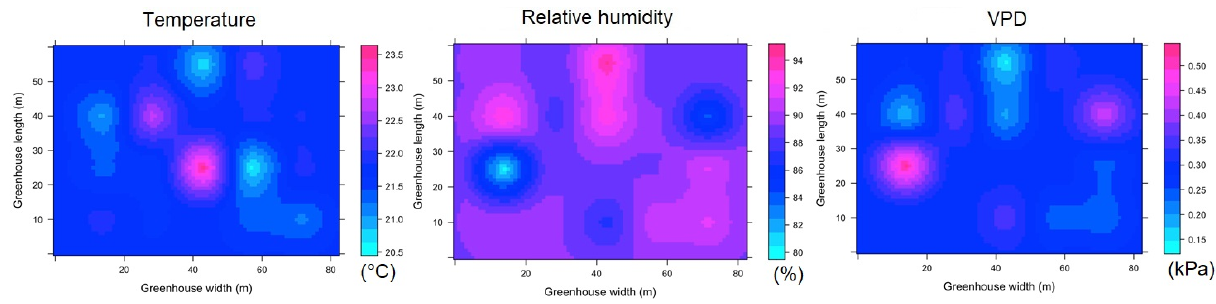
Figure 15. Spatial distribution predicted by kriging, for temperature, relative humidity and VPD in HGT2 and for ESRL 1.